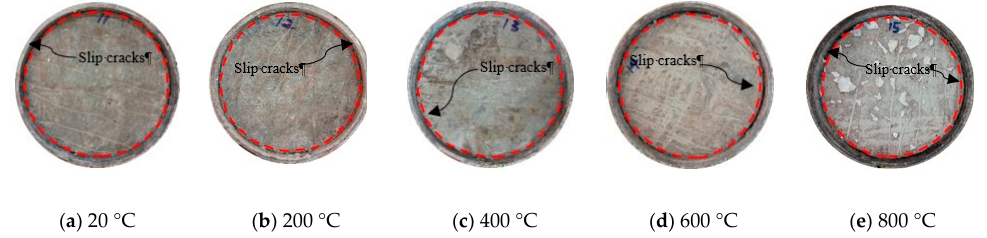
Figure 9. Failure pattern of the loading end after push-out test.